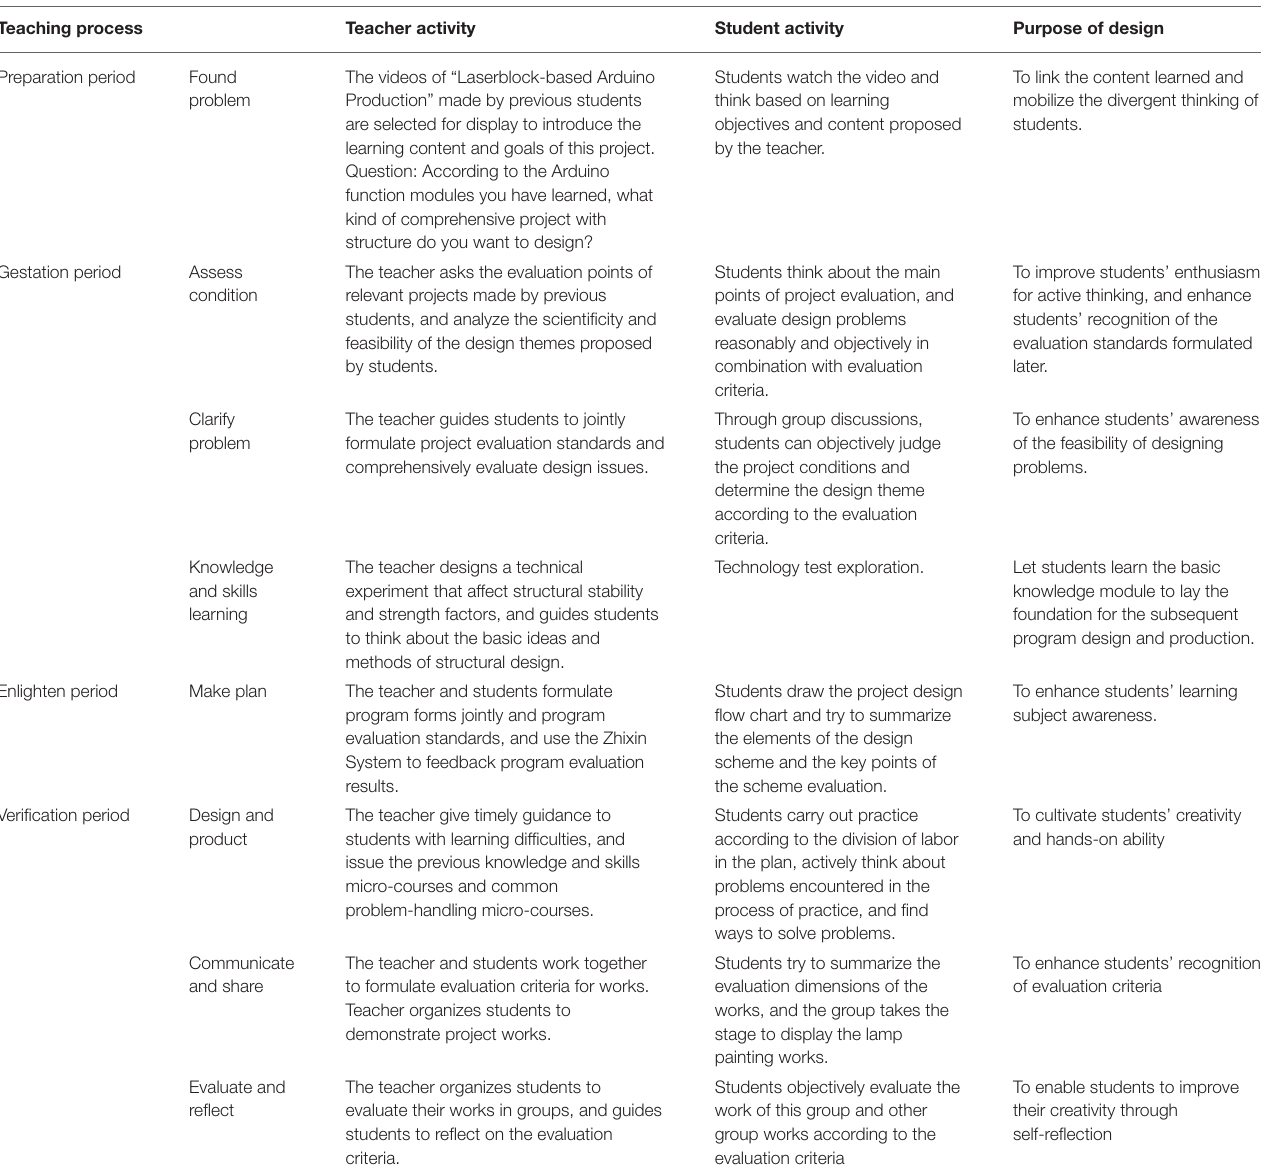
TABLE 1 | The teaching activities of the third round of action